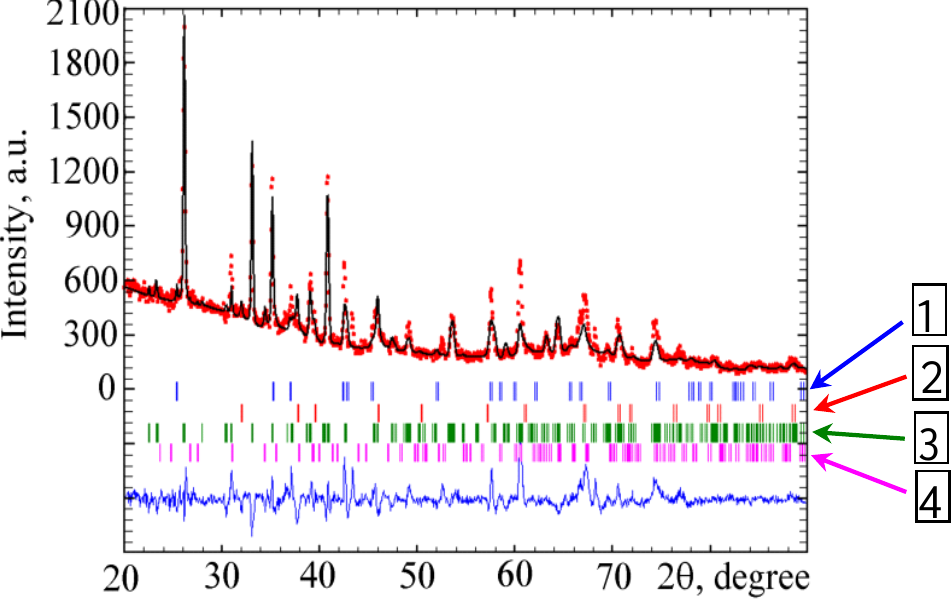
Figure 6. The observed (red dots at top), calculated (lines in the middle) and differential (blue line at the bottom) XRD patterns (in CuK α -radiation) of the PEO layer synthesized on the AK9 alloy in a weakly alkaline basic electrolyte of 3 g/L KOH + 2 g/L Na 2 SiO 3 composition. The numbers indicate the reflections corresponding to (1) α -Al 2 O 3 , (2) γ -Al 2 O 3 , (3) SiO 2 and (4) Al 2 O 3 · SiO 2 phases. All compounds in the composition of the PEO layer were detected by XRD method (DRON-3.0, in Cu-K α radiation). The obtained XRD data were refined with the use of the FullProf program [25]. The refined crystallographic parameters of all phases and their contents are presented in Table